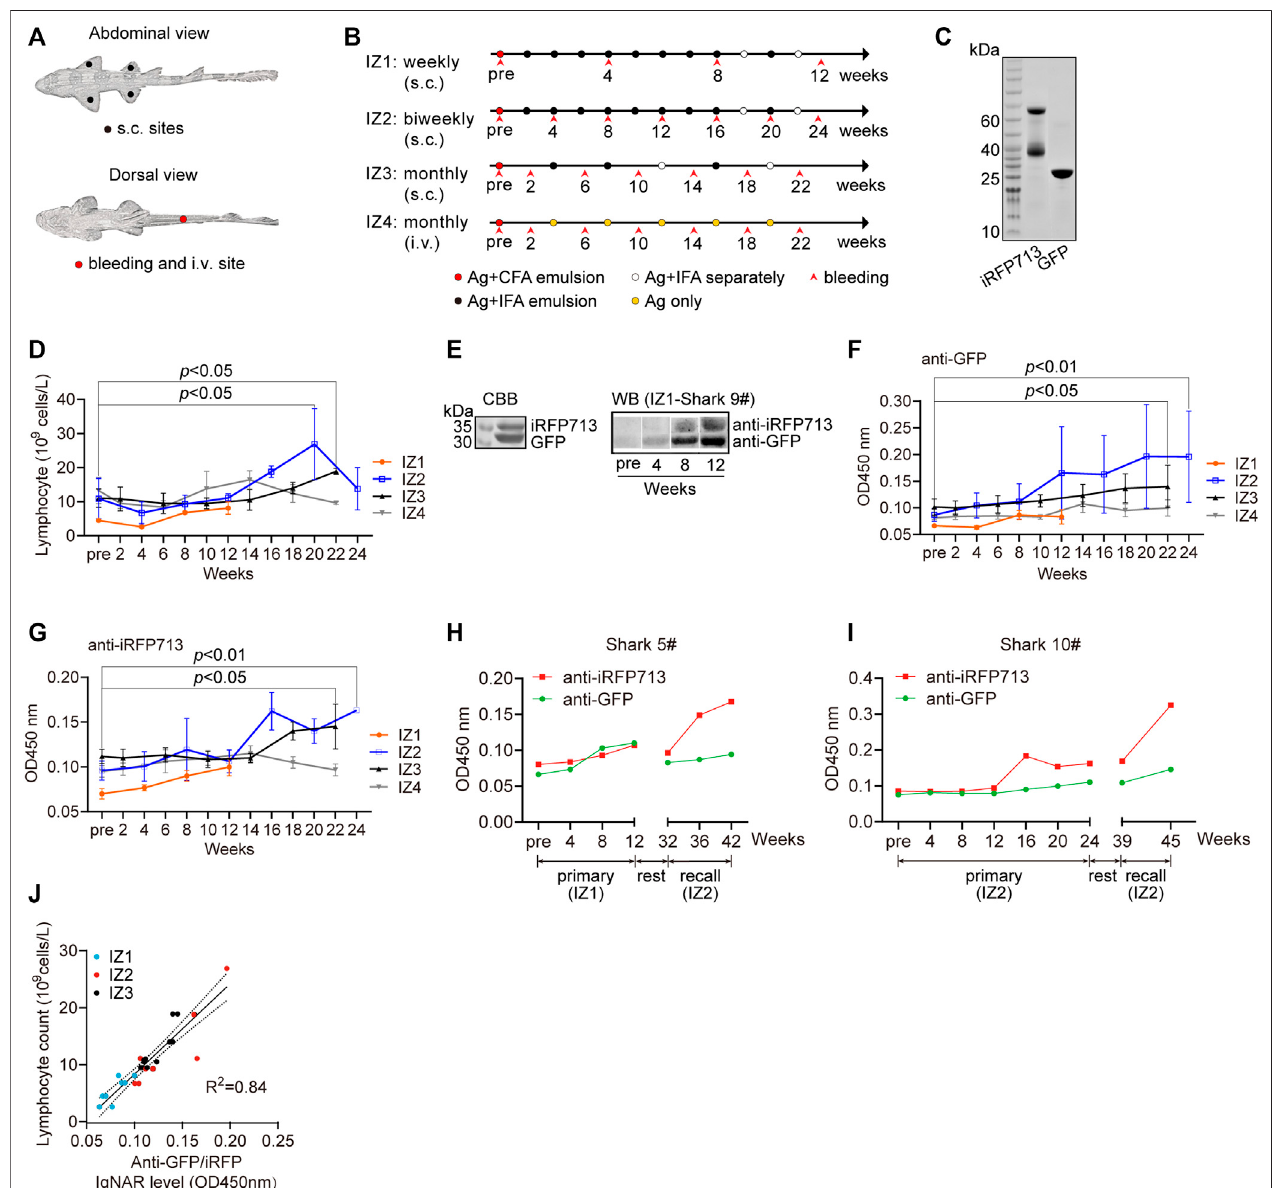
FIGURE2| Immuneresponsesofbamboosharkstoimmunization. (A,B) Theinjectionandbleedingsites (A) andtheimmunizationschedulesoffourimmunization programs (B) . s.c., subcutaneous; i.v., intravenous; Ag, antigen mixture; CFA, complete Freund ’ s adjuvant; and IFA, incomplete Freund ’ s adjuvant. (C) SDS-PAGE of twopuri fi edantigens,GFPandiRFP713. (D) Lymphocytecountsincreasedduringimmunization( n (cid:1) 3).Statisticalsigni fi canceforthelastpost-immunizationvs.thepre- immunization is indicated by asterisks (* p < 0.05). (E) Identi fi cation of antigen-speci fi c IgNARs in plasma. (F, G) Antigen-speci fi c IgNAR level in plasma increased during immunization ( n (cid:1) 3). Statistical signi fi cance for the post-immunization vs. the pre-immunization is indicated by asterisks (* p < 0.05, ** p < 0.01). (H, I) Two sharks with extended immunization showed an enhanced IgNAR level. (J) IgNAR level were correlated with lymphocyte counts ( n (cid:1) 29).